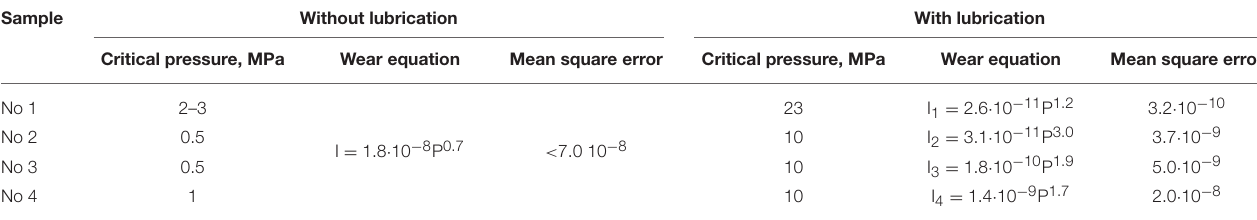
TABLE 2 | Critical pressure and wear equation when tested for wear of the studied alloys without lubrication and with lubrication. Sample Without